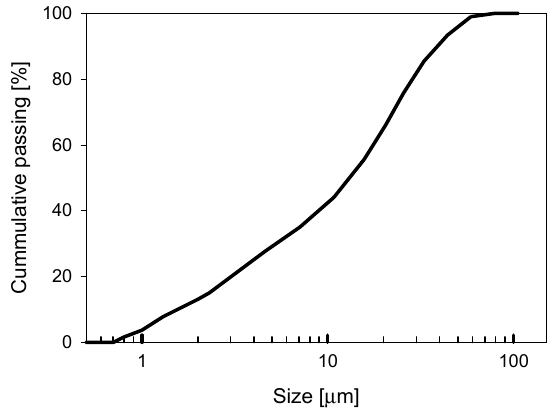
Figure 3. Particle size distribution of kaolin particles.